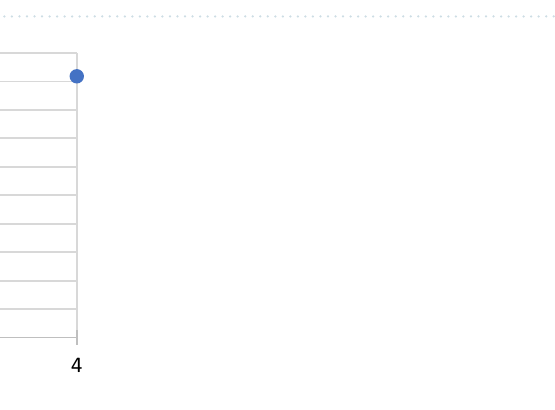
3 m, 3 h 2.69 10 2 − − = ×